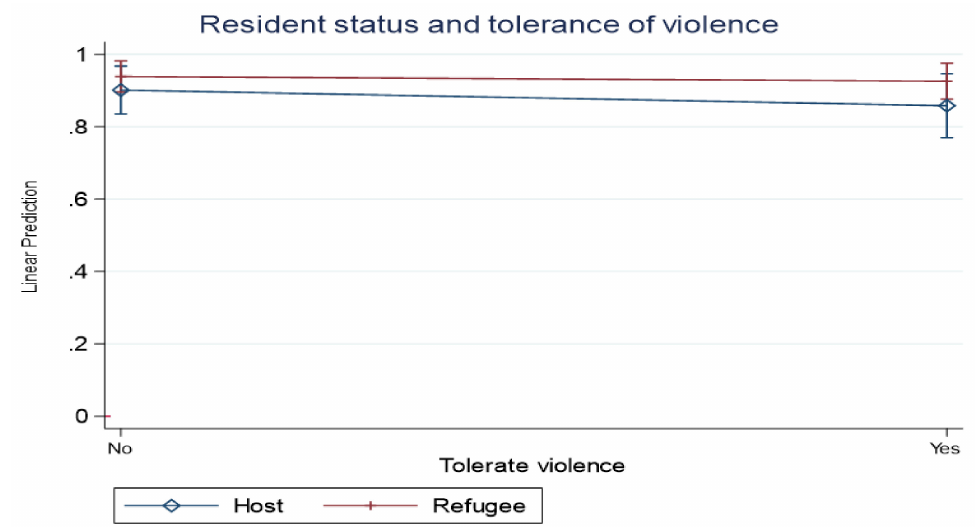
Figure 2. Marginal effects of resident status and tolerance of violence against women on experiences of psychosocial